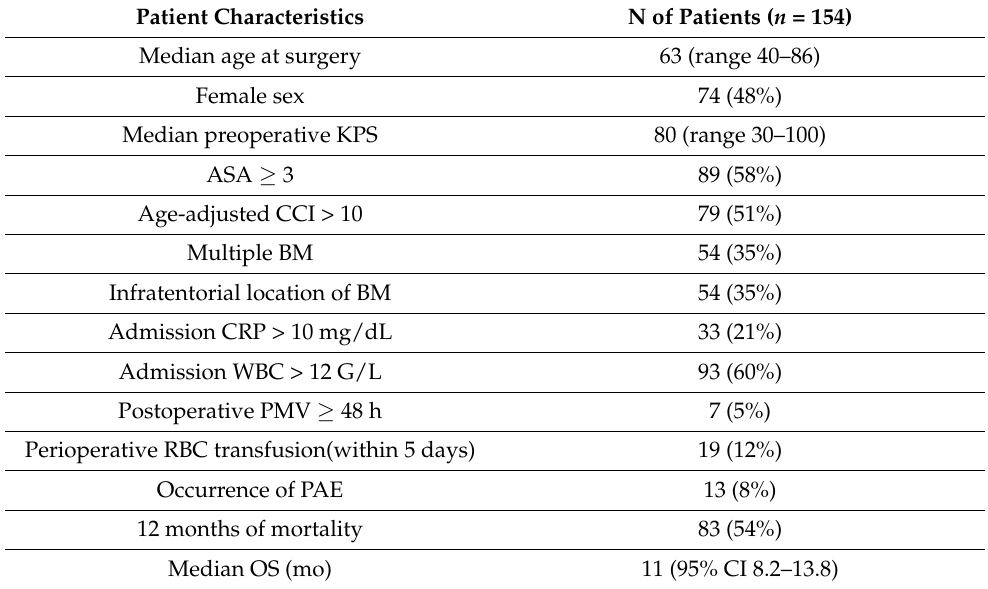
Table 1. Patient